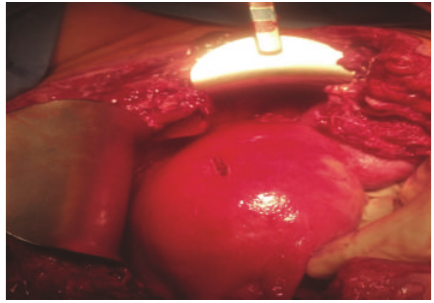
Figure 2: Intra-operative uterus examination demonstrating good vascularity on postoperative day number 12.